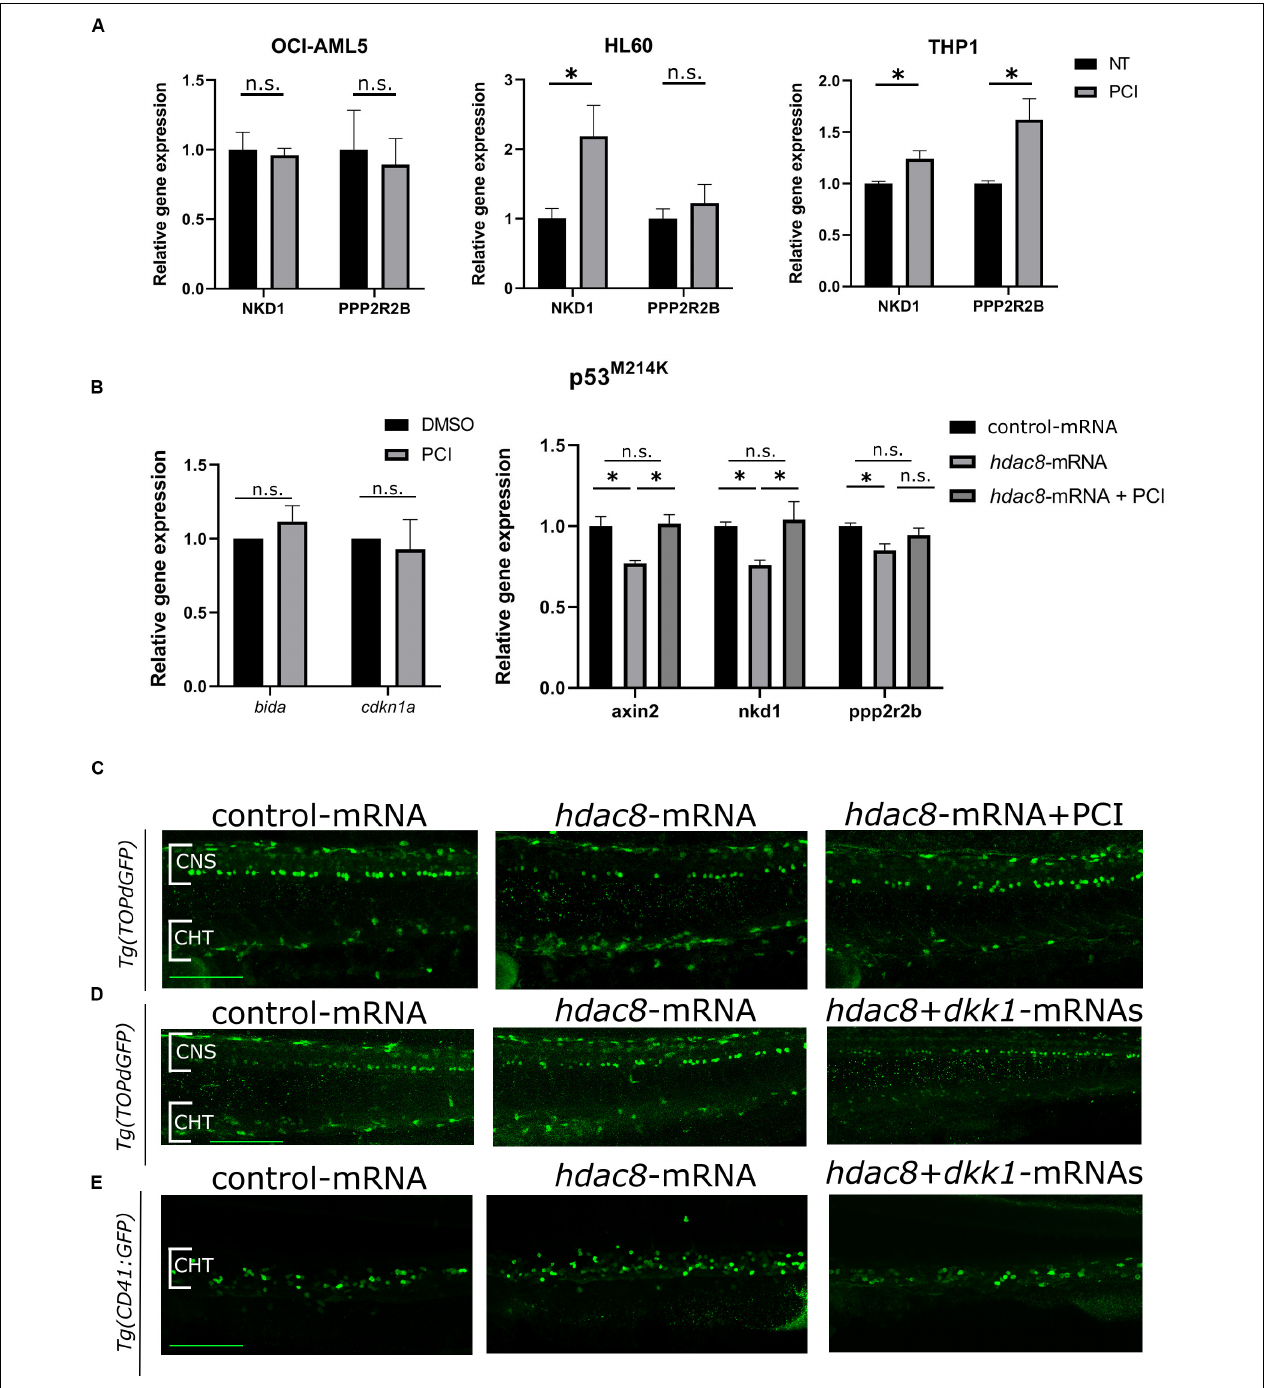
FIGURE 4 | Canonical Wnt pathway modulation by HDAC8. (A) Canonical Wnt pathway modulation by PCI in OCI-AML5, HL60, and THP-1 cell lines. NKD1 and PPP2R2B Wnt inhibitors were analyzed by RT-qPCR. Results are presented as mean ± SD from three independent experiments. * p < 0.05, Student’s t -test. (B) WNT pathway modulation by PCI in zebrafish mutant p53 M 214 K . bida and cdkn1a apoptotic genes and axin2 , nkd1 and pppr2r2b WNT target genes were analyzed by RT-qPCR. Results are presented as mean ± SD from three independent experiments. n.s.: not significant, * p < 0.05; One sample t -test for apoptotic genes, one-way ANOVA followed by Tukey post hoc correction for canonical WNT pathway genes. (C) Representative images of canonical Wnt modulation by hdac8 overexpression and PCI on HSPCs in the CHT of the Wnt reporter line Tg(TOPdGFP) . (D,E) Representative images of canonical Wnt modulation by hdac8 overexpression and Wnt inhibition by dkk1b injection on HSPCs in the CHT of the Wnt reporter line Tg(TOPdGFP) and of the HSPCs reporter line Tg(CD41:GFP) . NT, not treated; CNS, central nervous system; CHT, caudal hematopoietic tissue. Scale bar represents 100 µ m.